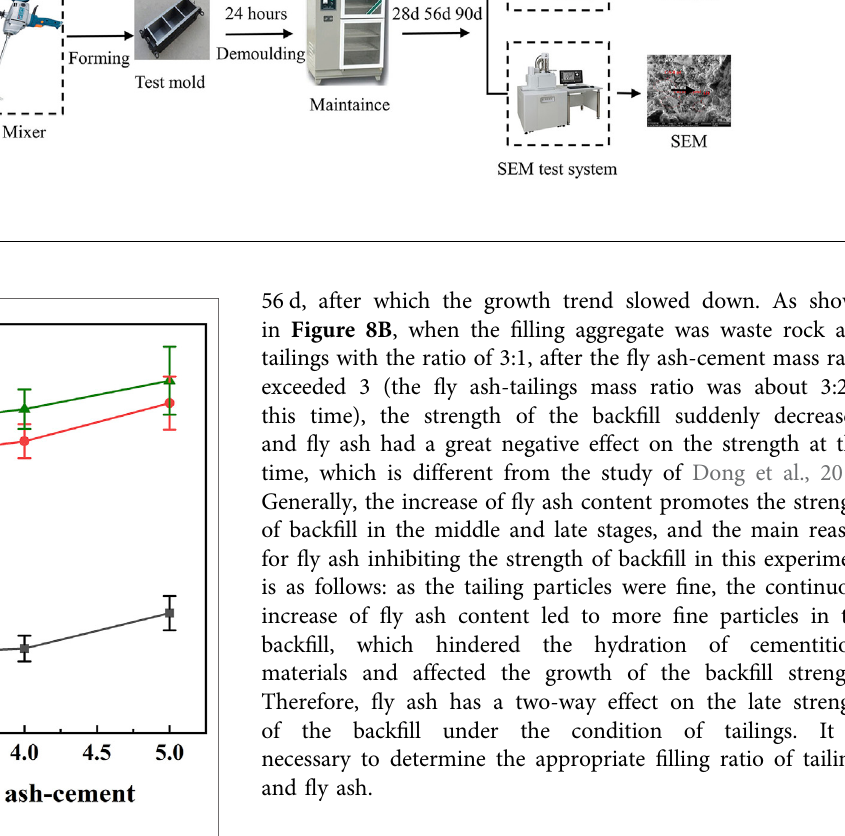
Frontiers in Materials |